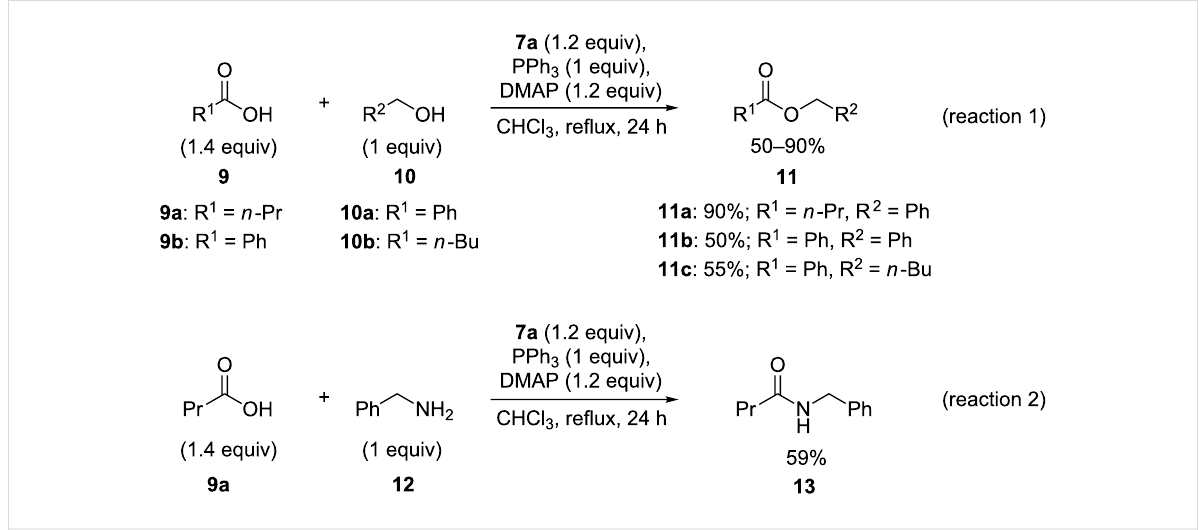
Scheme 3: Benziodadiazole 7a mediated oxidatively assisted esterification and amidation reactions.